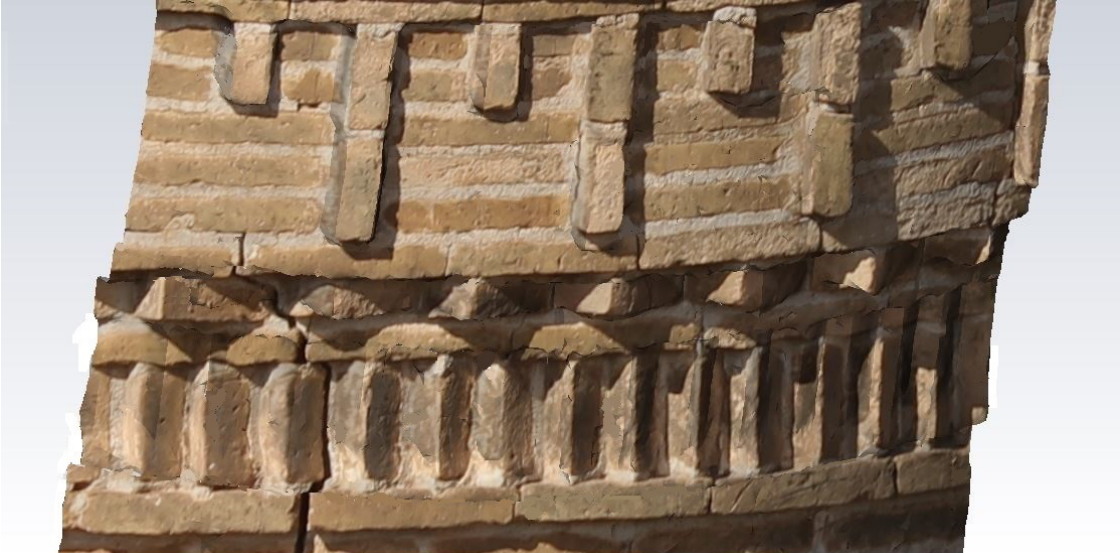
Figure 9: A part of the textured model (source: prepared by the